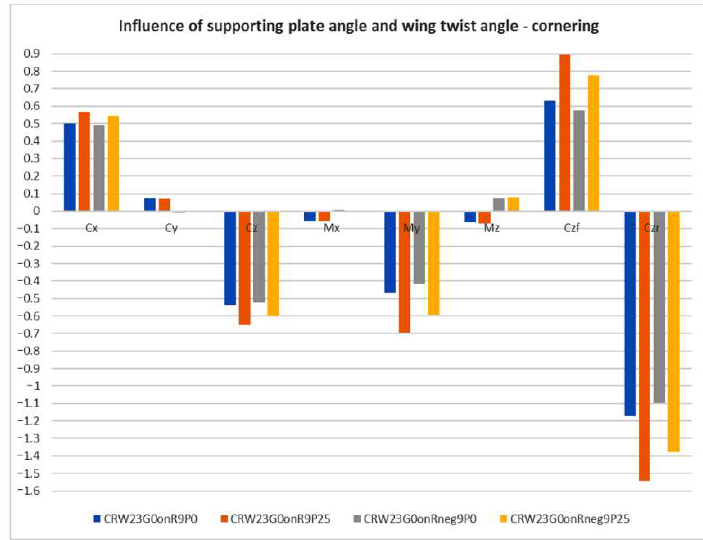
Figure 26. Influence of the supporting plate angle and wing twist angle-cornering.